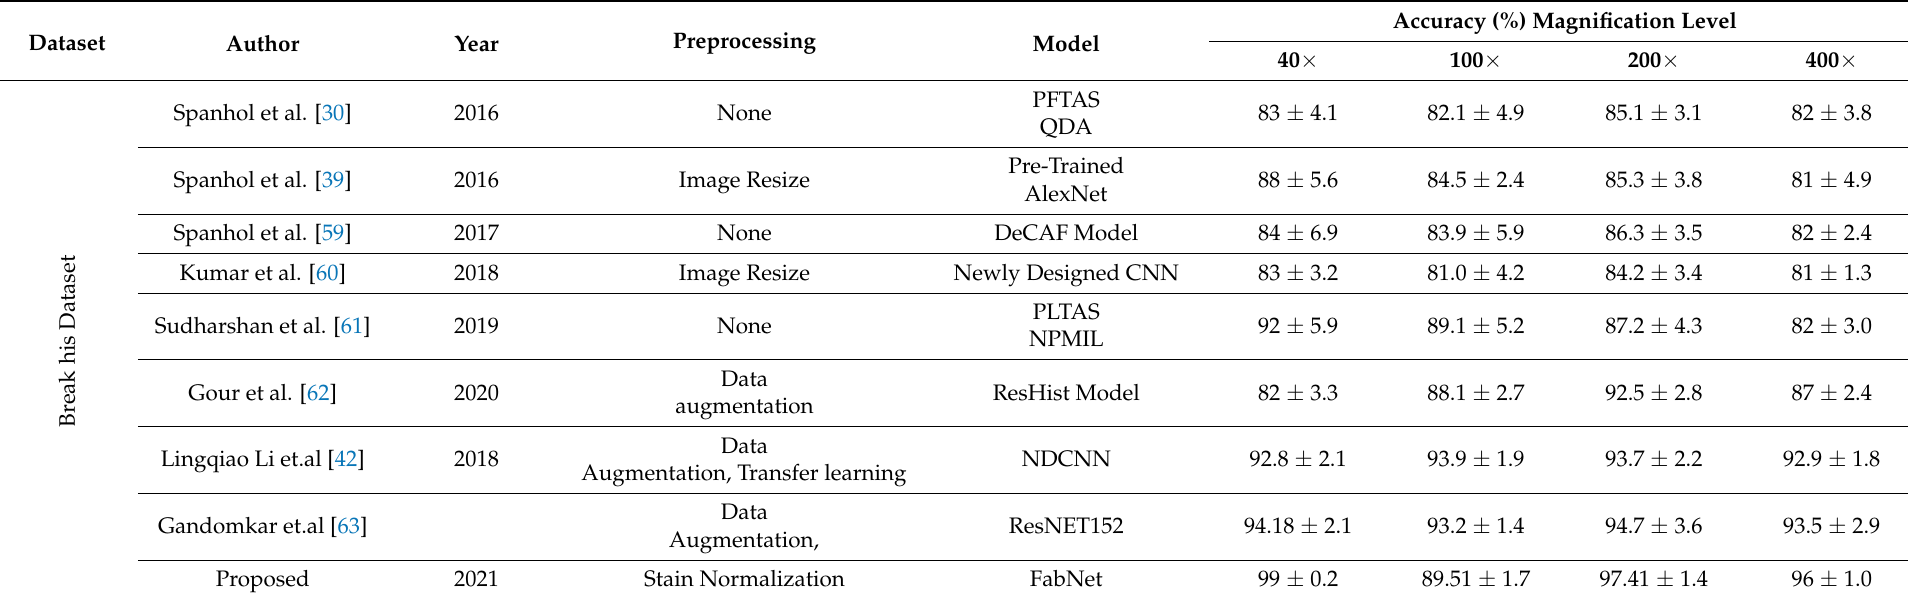
Table 9. A comparison of FabNet performance with existing studies on BreakHis histology dataset.